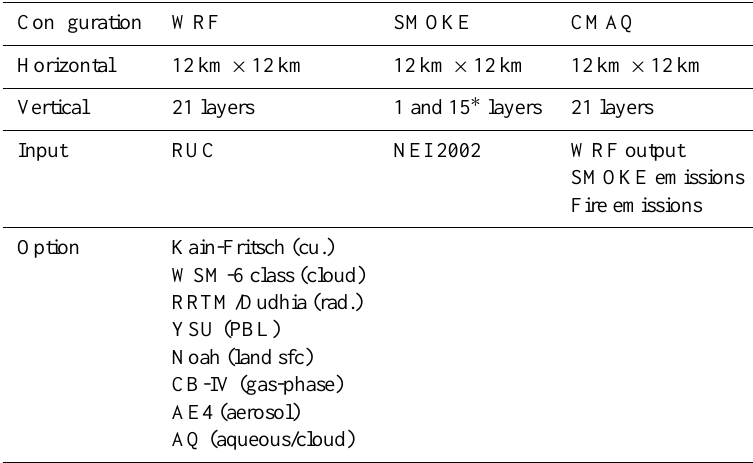
Table 1. Model inputs and